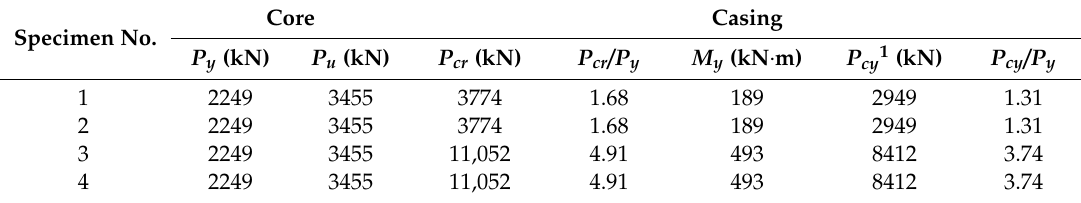
Table 2. Specimen Table 2. Specimen strength.